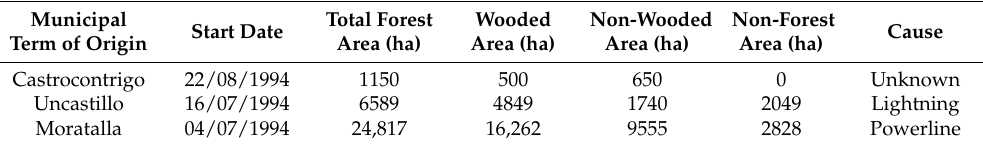
Table 1. Fire data of the studied forest fires [37].